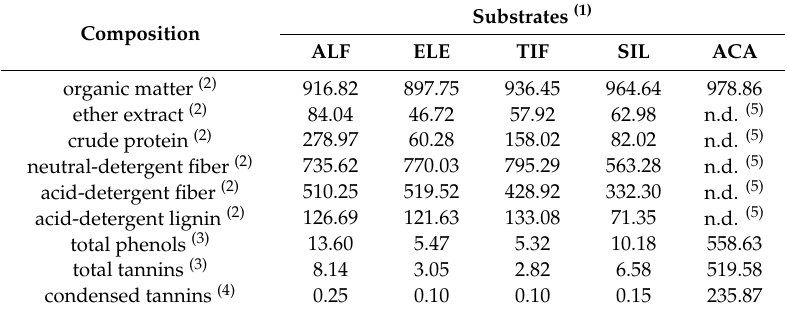
Table 1. Chemical composition of substrates used during the assay of in vitro fermentation